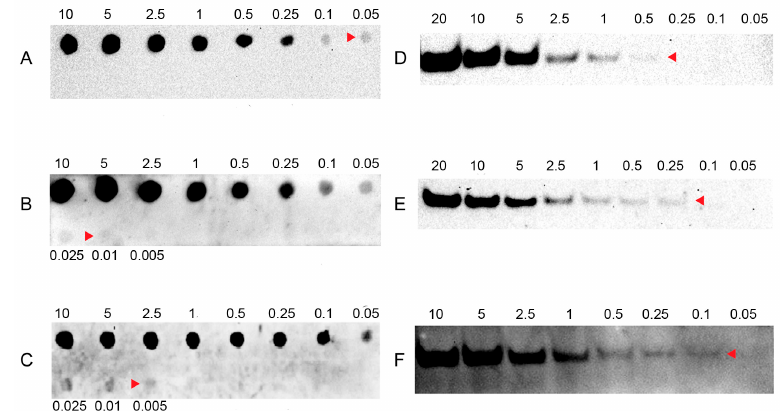
Figure 2. Sensitivity of LHSPD with different detection systems. ( A , D ) Hybridizations of different concentrations of ( Biotin ) -miD156rk with 0.1 pmol of miD156 detected by the LHSPD strategy with biotin-luminol system; ( B , E ) Hybridizations of different concentrations of ( DIG ) -miD156rk with 0.1 pmol of miD156 detected by the LHSPD strategy with DIG-CDP Star system; ( C , F ) Hybridizations of different concentrations of ( Biotin ) -miD156rk with 0.1 pmol of miD156 detected by the LHSPD strategy with biotin-CDP Star system.